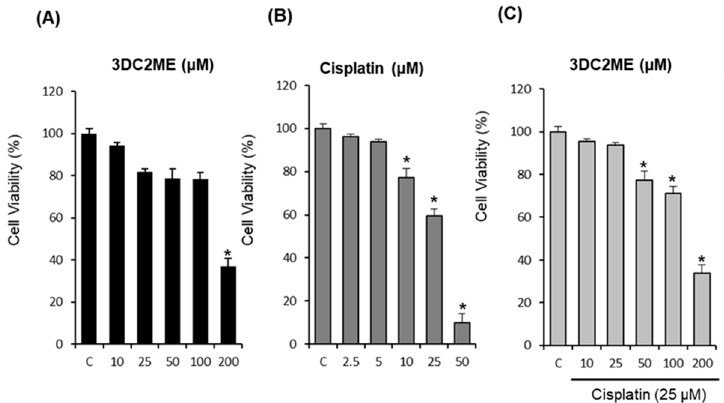
Figure 6. Effects of co-treatment with 3DC2ME and cisplatin in HeLa human cervical carcinoma cells for 24 h (MTT assay). ( A ) Effect of 3DC2ME on HeLa cell viability. ( B ) Effect of cisplatin on HeLa cell viability. ( C ) Effect of co-treatment with 3DC2ME and cisplatin on HeLa cell viability. Control cells were treated with the vehicle only (mean ± SD, * p < 0.05 compared to the control).